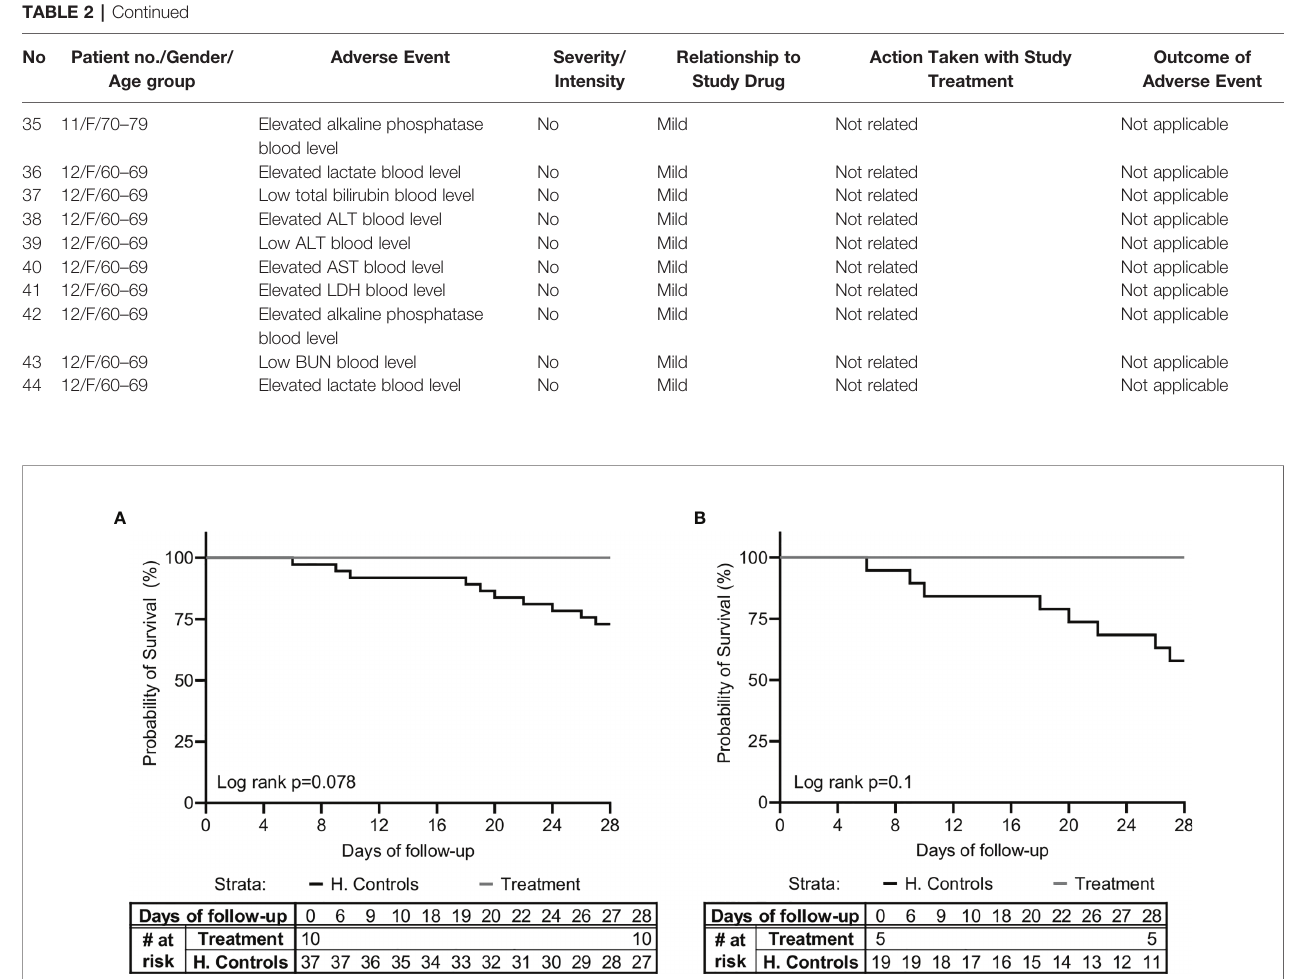
FIGURE 2 | Kaplan-Meier survival curve. A comparison of survival between the study group ( n =10) and matched-historical controls from the same hospital ( n =37) for (A) all patients, and (B) patients with pneumonia ( n =5 for the study group, n =19 for the historical controls), is shown. Matched controls were selected from all patients admitted to ICU with a diagnosis of sepsis between 2014 – 2019 and were matched by gender, age ± 7, Sequential Organ Failure Assessment (SOFA) score ±2 at presentation, and source of